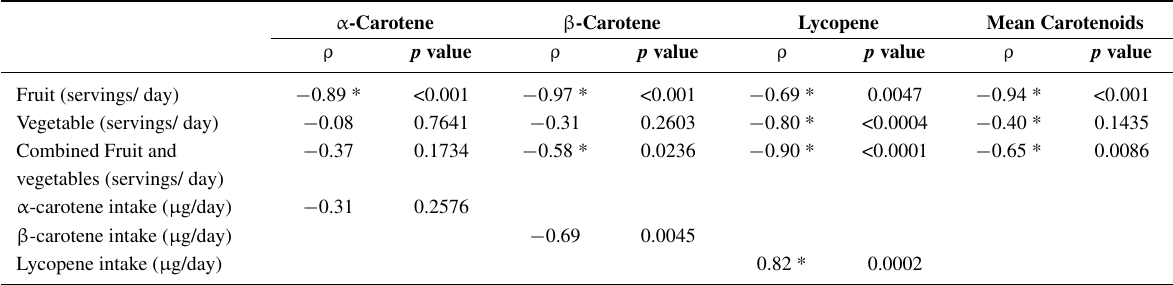
Table 3. Relationship between partial correlation coefficients between fruit, vegetable and dietary carotenoid intake, overall skin reflectance and absorption spectra of common carotenoids as measured by